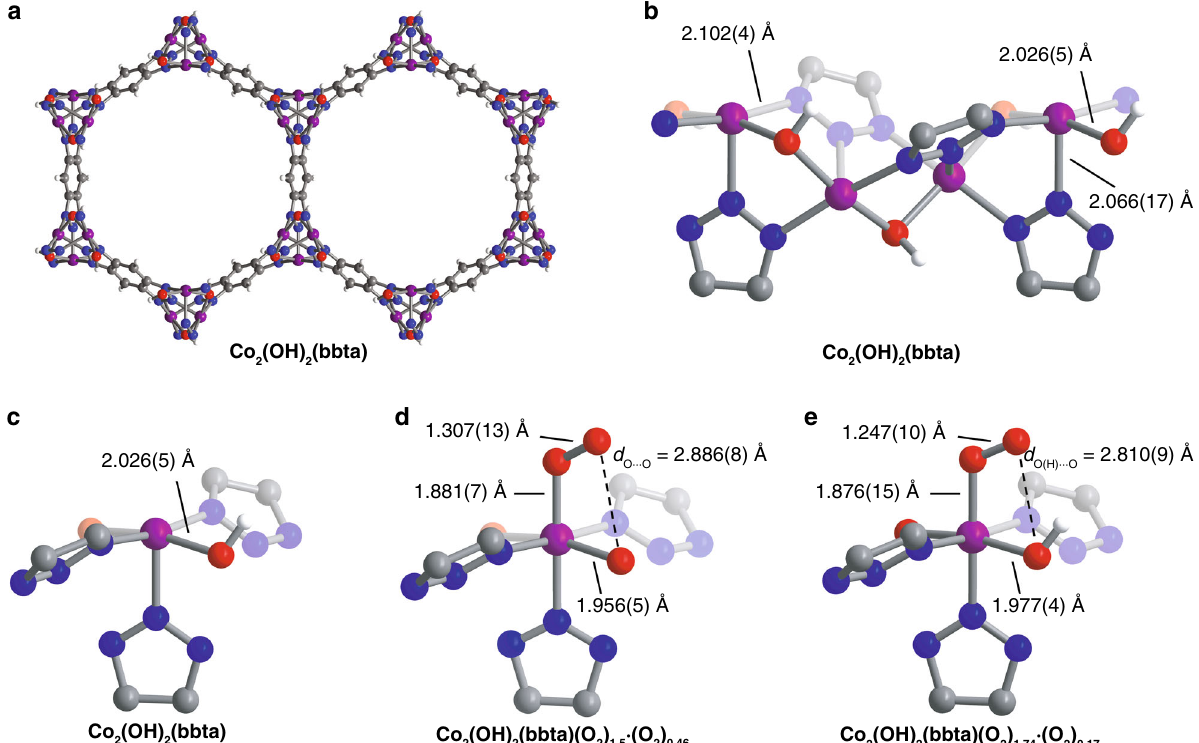
Fig. 4 Structures of activated and O 2 -dosed Co 2 (OH) 2 (bbta). a – c Structures of activated Co 2 (OH) 2 (bbta) as determined by Rietveld re fi nement against neutron powder diffraction data obtained at 8 K, showing a the hexagonal framework channels with the view down the c axis, b a truncated view of the coordinatively-unsaturated metal centers lining the pores, and c a single coordinatively-unsaturated cobalt(II) center. d Structure of Co 2 (OH) 2 (bbta) dosed with 1 bar of O 2 , as determined from Rietveld re fi nement against powder X-ray diffraction data obtained at 195 K. Hydrogen atom positions could not be determined from the measurement. The 0.46 equivalents of O 2 found within the pores are not shown for clarity. e Structure of Co 2 (OH) 2 (bbta) (O 2 ) 1.74 ·(O 2 ) 0.17 determined from Rietveld re fi nement against neutron powder diffraction data of Co 2 (OH) 2 (bbta) dosed with 1 equivalent of O 2 per cobalt at 8 K. The 0.17 equivalents of O 2 found within the pores are not shown for clarity. In b , c , and e , only one orientation is shown for the half-occupancy hydrogen atom of the hydroxo group. Slight deviations in the bond distances derived from the neutron and X-ray diffraction data are likely a result of differences in experimental conditions, as well as the improved scattering of the O atoms in neutron diffraction. Purple, red, blue, gray, and white spheres represent Co, O, N, C, and H atoms,